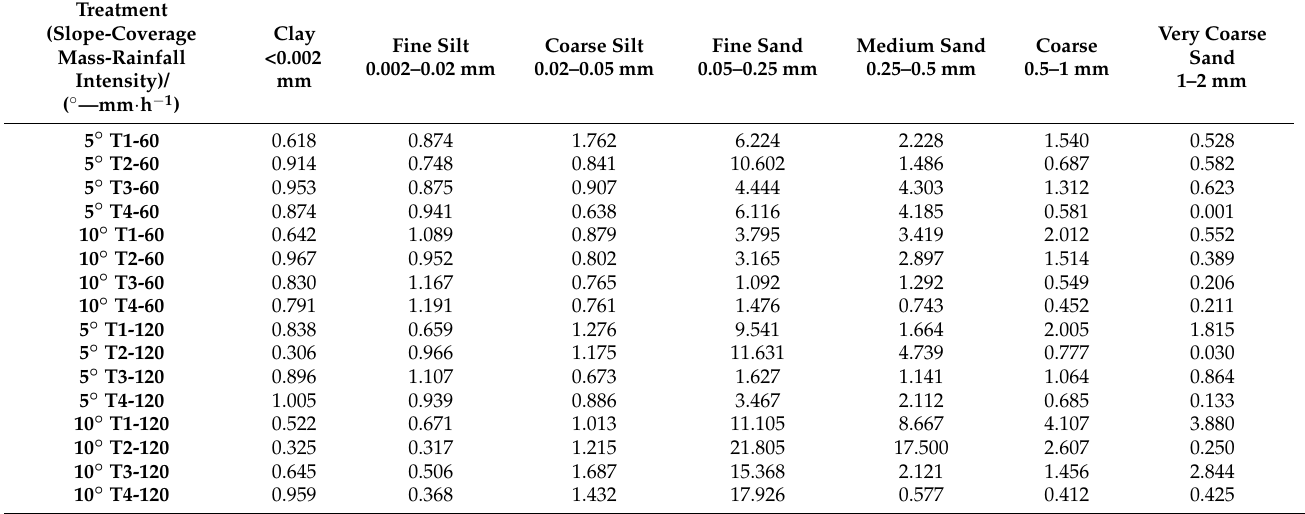
Table 4. Enrichment ratio of eroded sediment in each size fraction under different treatment conditions. Treatment (Slope-Coverage